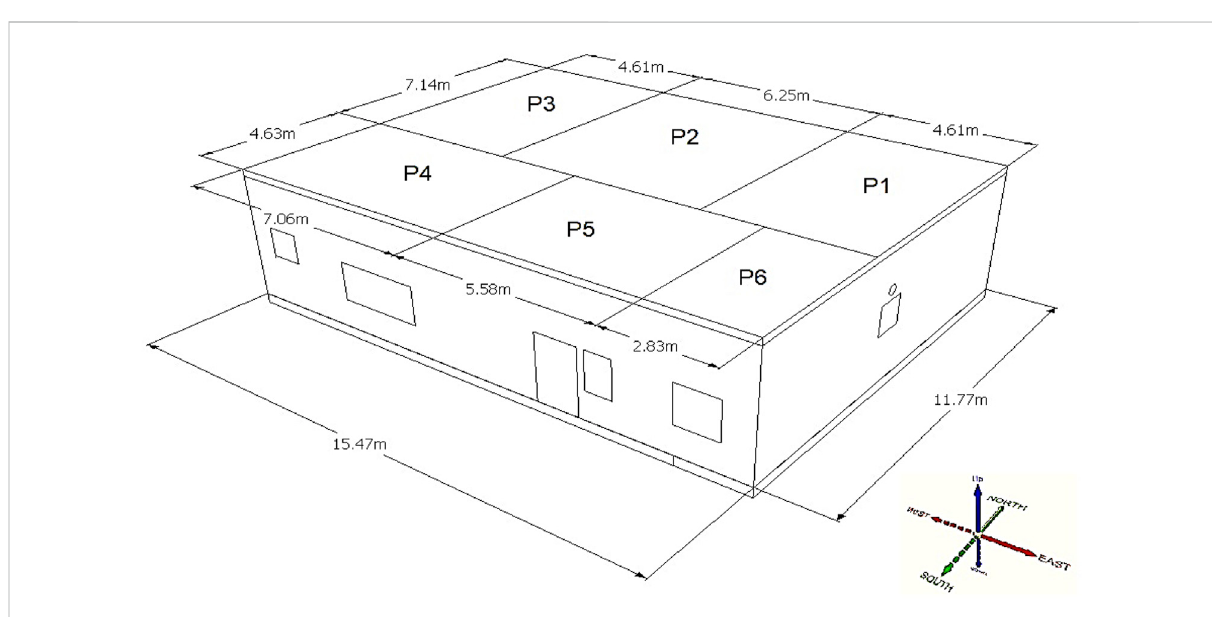
FIGURE 2 Sketch of residential building in Peshawar